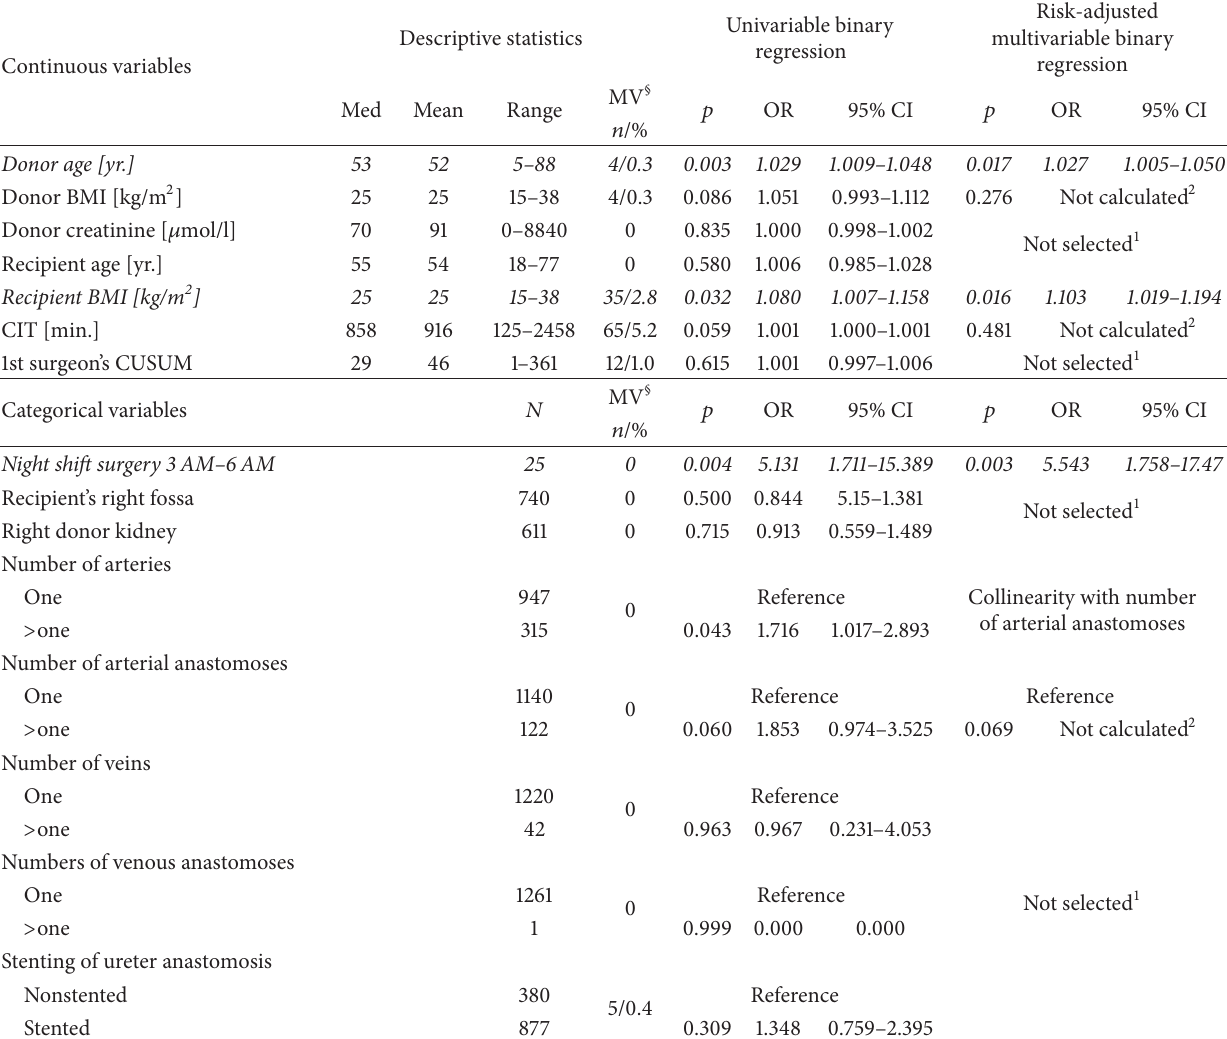
Table 4: Regression analysis of the risks for perioperative graft loss ( 𝑛 = 55 ). Shown are the results of univariable and multivariable binary regression analyses to determine the odds ratios of the investigated variables for the risk of perioperative graft loss ( 𝑛 = 55 ) during primary hospitalization period. Analyzed were all 1262 cases with standard kidney transplantations into nonpreoperated sites between 1 January 2000 and 31 October 2013. Included into risk-adjusted multivariable analyses were only transplant variables with a 𝑝 value < 0.2 in univariable regression